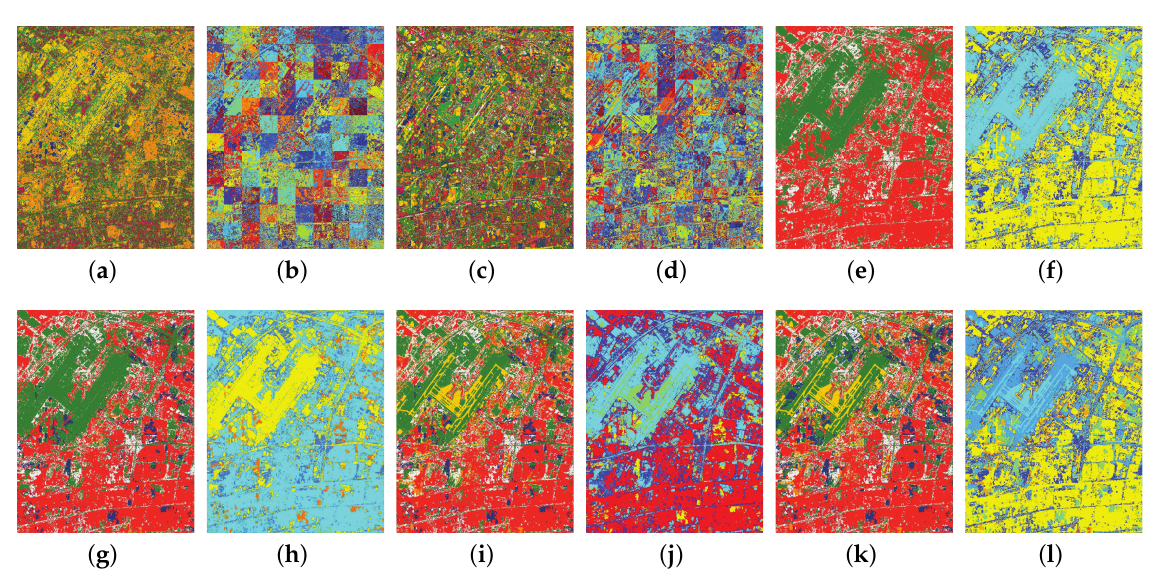
Figure A7. Classification results of Tianjin Airport with different class numbers. ( a ) Initial results with PCST. ( b ) Initial results with “label2rgb”. ( c ) Result after optimization with PCST. ( d ) Result after optimization with “label2rgb”. ( e ) Result of 3 classes with PCST. ( f ) Result of 3 classes with “label2rgb”. ( g ) Result of 5 classes with PCST. ( h ) Result of 5 classes with “label2rgb”. ( i ) Result of 7 classes with PCST. ( j ) Result of 7 classes with “label2rgb”. ( k ) Result of 9 classes with PCST. ( l ) Result of 9 classes with “label2rgb”.